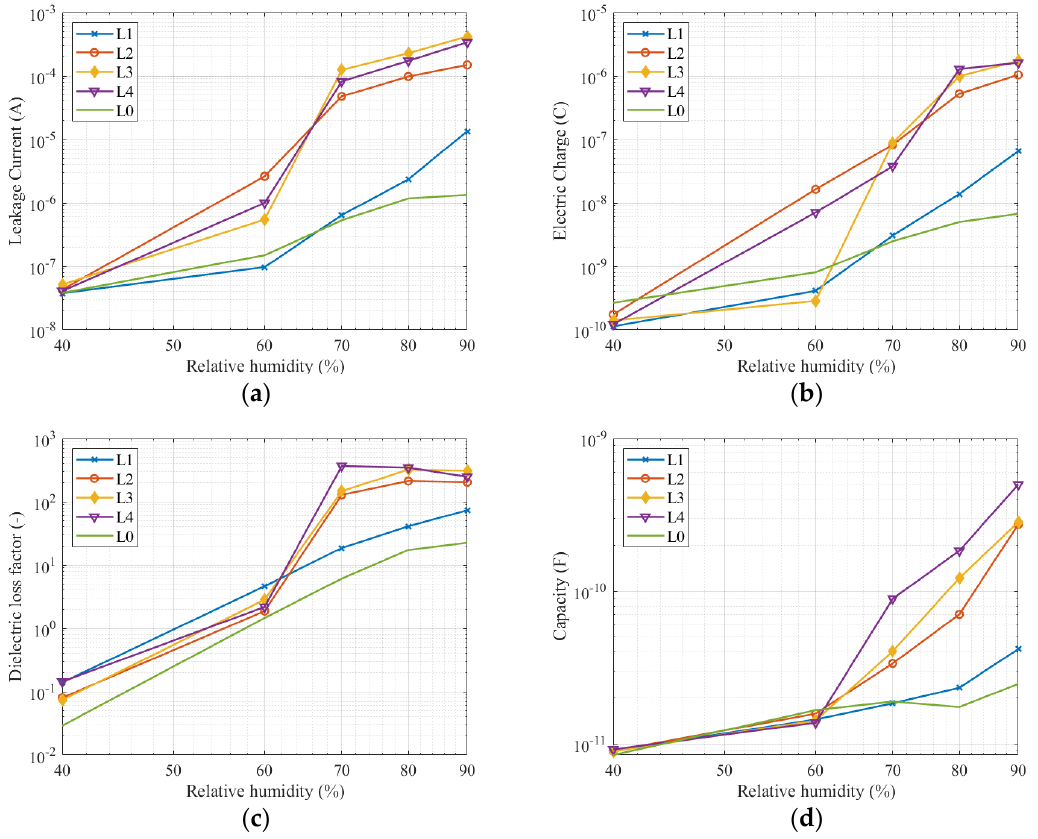
Figure 9. Measured quantities at frequency 113 Hz: ( a ) leakage current; ( b ) electric charge; ( c ) dielectric loss factor; ( d ) capacity.